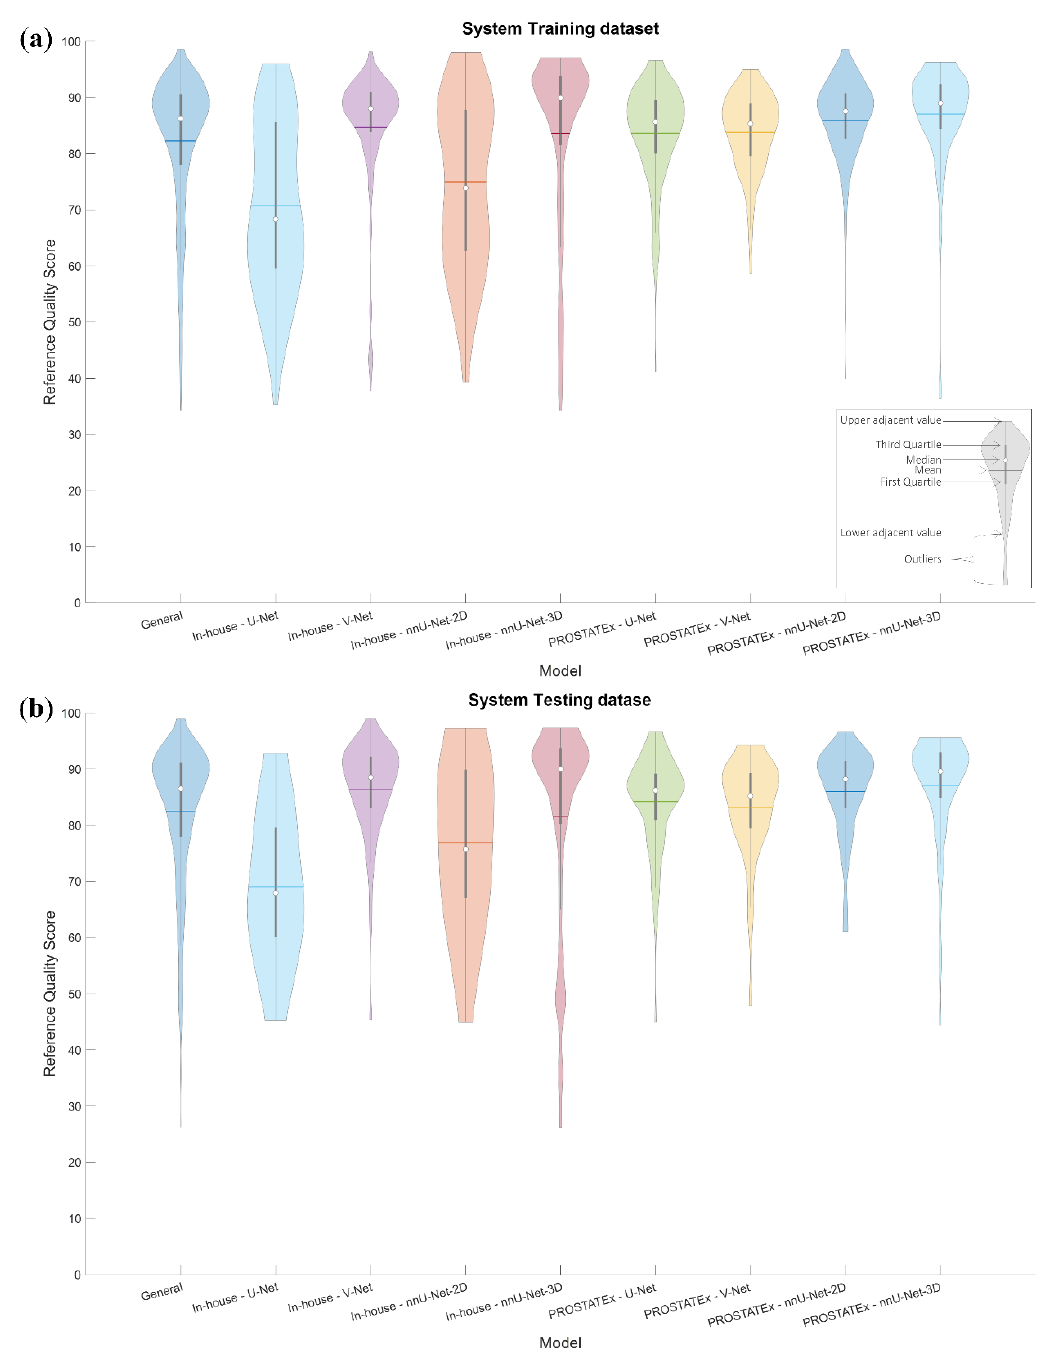
Figure 3. Violin plots visualizing the distribution of the reference quality scores for the system training ( a ) and testing ( b ) datasets, both combined and for each combination of dataset and segmentation